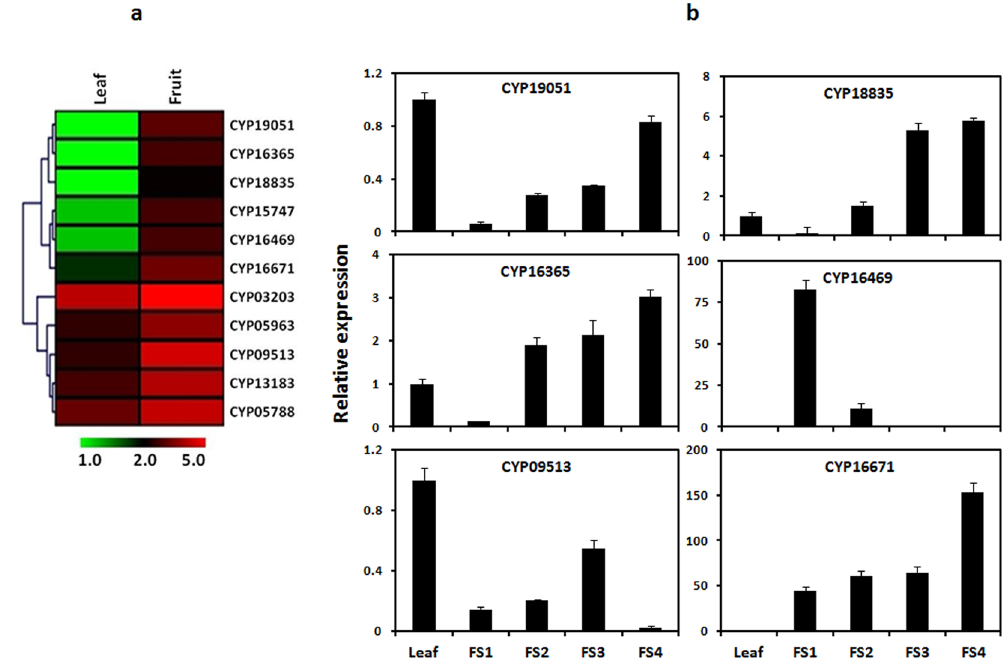
Figure 5. Identification and differential gene expression of members of CYP450 gene family putatively involved in triterpenoid biosynthesis. ( a ) Differentially expressed members of CYP450 gene family. Two columns represent leaf and fruit. Individual contigs encoding different members of CYP450 gene family are represented in rows. For each contig, log 2 tpm value obtained in leaf and fruit transcriptome datasets was used for clustering to visualize differential expression. ( b ) Validation of differential expression of selected members of CYP450 gene family by qRT-PCR in different plant parts. Leaf, Mature leaf; FS1, Fruit stage 1; FS2, Fruit stage-2; FS3, Fruit stage-3 and FS4, Fruit